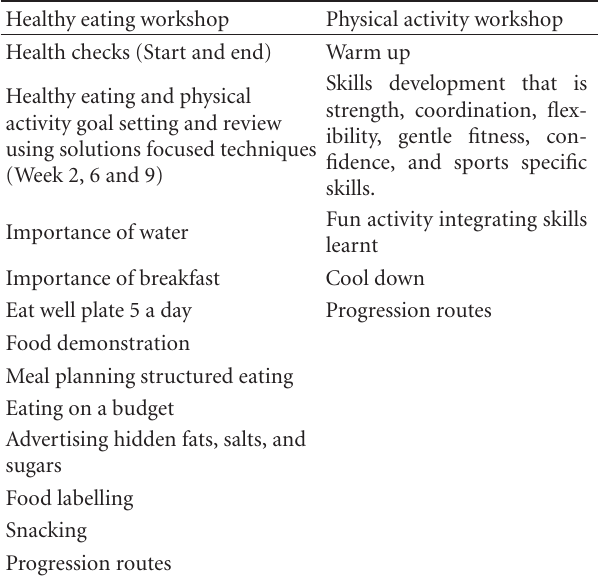
Table 1: Overview of OBOL